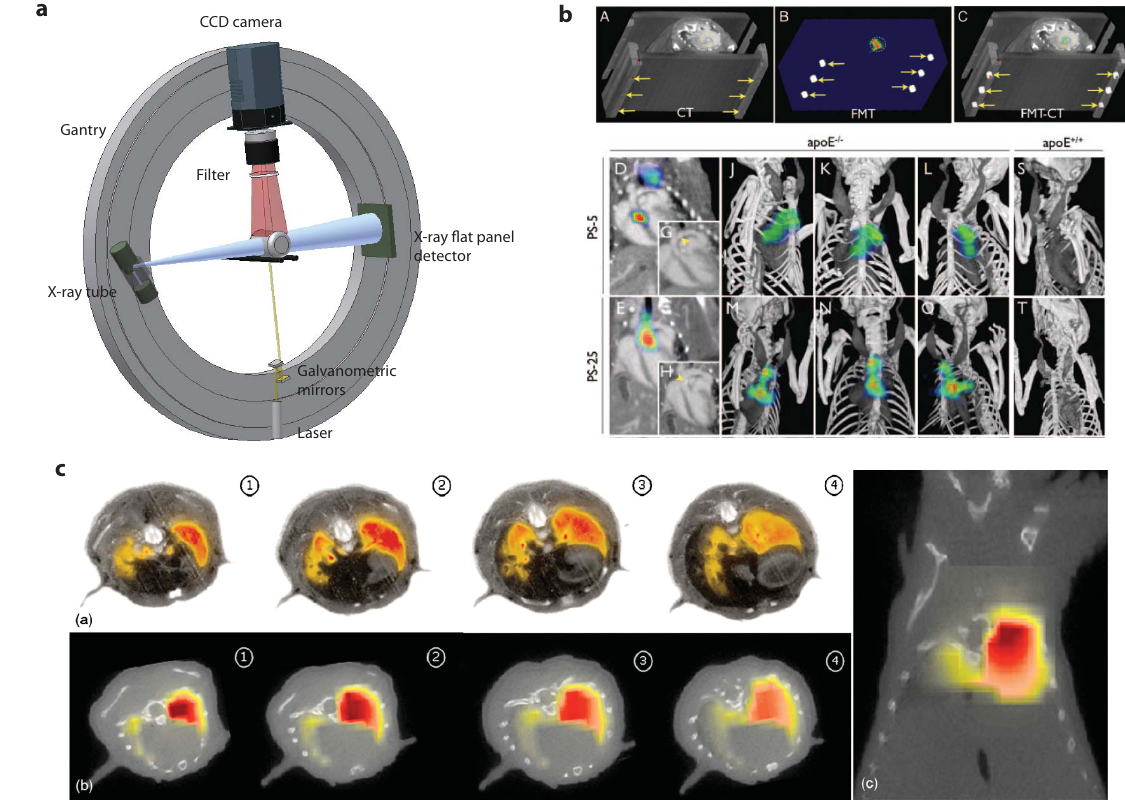
Figure 4. Applications: ( a ), Schematic of a hybrid FMT/CT system. Perpendicular to the X-ray tube and flat panel detector axis the FMT instrumentation is mounted consisting of a laser source, a scanning device and a CCD camera. All components are mounted on a rotating gantry holding the sample in its center.( b ), Sequential FMT/CT example of artherosclerotic plaques in mice. A through C, Image co-registration is based on fiducial landmarks (arrows) that are incorporated into the animal holder and are identifiable on CT (A) and FMT (B). The software co-aligns these fiducial markers to created a hybrid data set (C). Fluorescence signal in the aortic root of an apoE − / − mouse is encircled. D and E, 2-dimensional FMT/CT long axis views of apoE − / − mice injected with respective protease sensors. Fluorescence signal is observed in the aortic root and arch, regions with high plaque load. G and H, CT only views of D and E. Arrow heads depict vascular calcification, likely colocalizing with plaques. J through O, 3-dimensional maximum intensity projection of hybrid data sets show skeletal and vascular anatomy and the distribution of fluorescence signal. Most signal is observed in the root and arch. S and T, FMT/CT after injection of respective sensor into wild-type mice (Adapted from [76]; reprinted with permission). ( c ), Hybrid imaging example of a lung inflammation mouse model. (a) Cryoslice images overlaid with normalized fluorescence image; reconstruction using weighted segments regularization (b) transversal slices and (c) coronal slice (Adapted from [82]; reprinted with